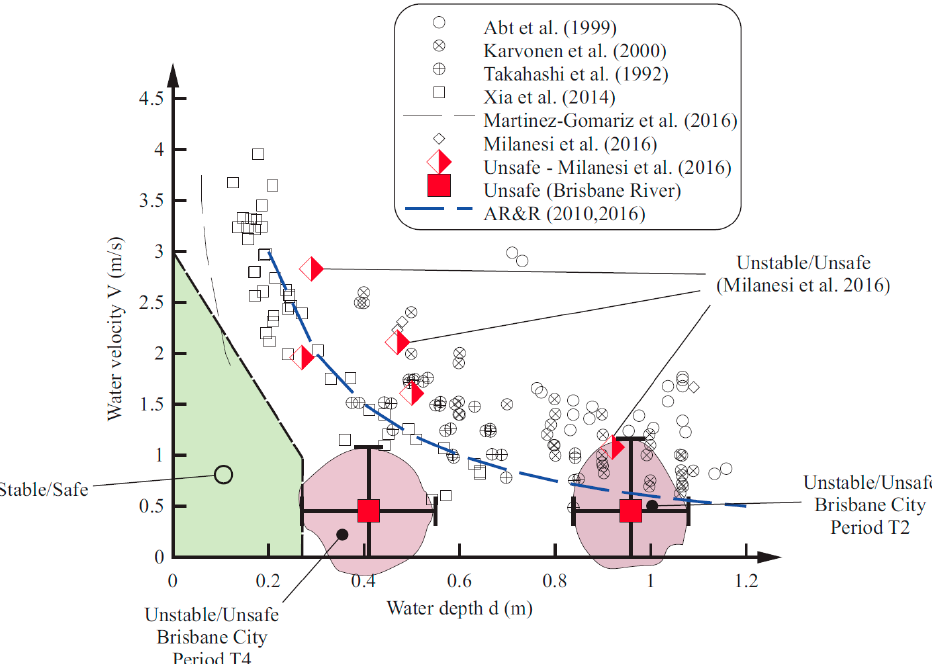
Figure 5. Relationship between water velocity and water depth for stability of human body in floodwaters. Comparison between field observations deemed unsafe for evacuation (Red symbols), full-scale tests with adults [11,18,19,23], model data of [14], current guidelines ([13,34] {Low hazard}) and new guidelines (Equation (2)). Scatter bars show the range of instantaneous velocity and water depth measurements.